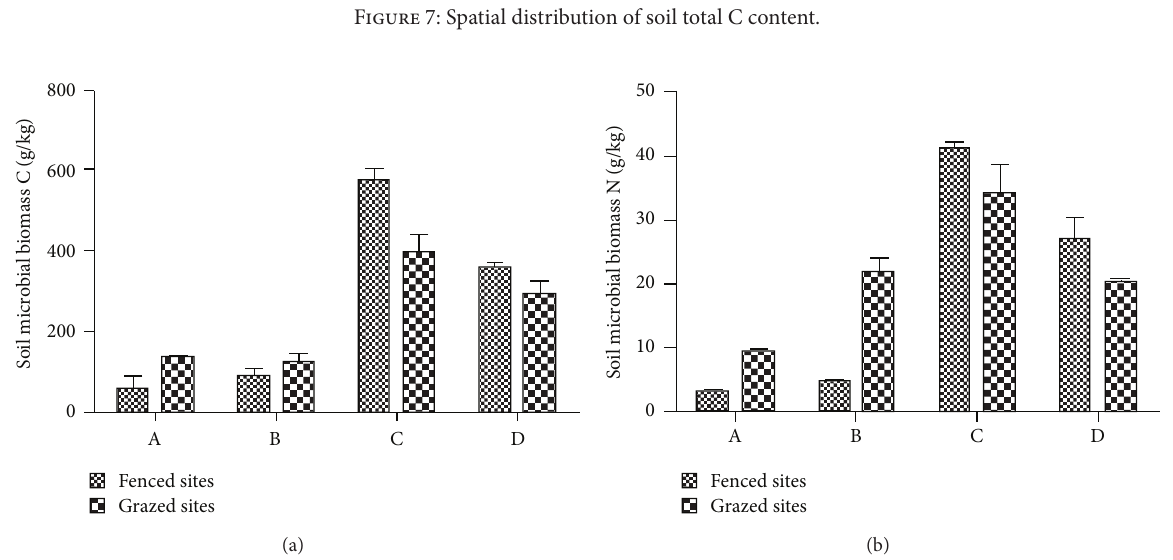
Figure 7: Spatial distribution of soil total C content.